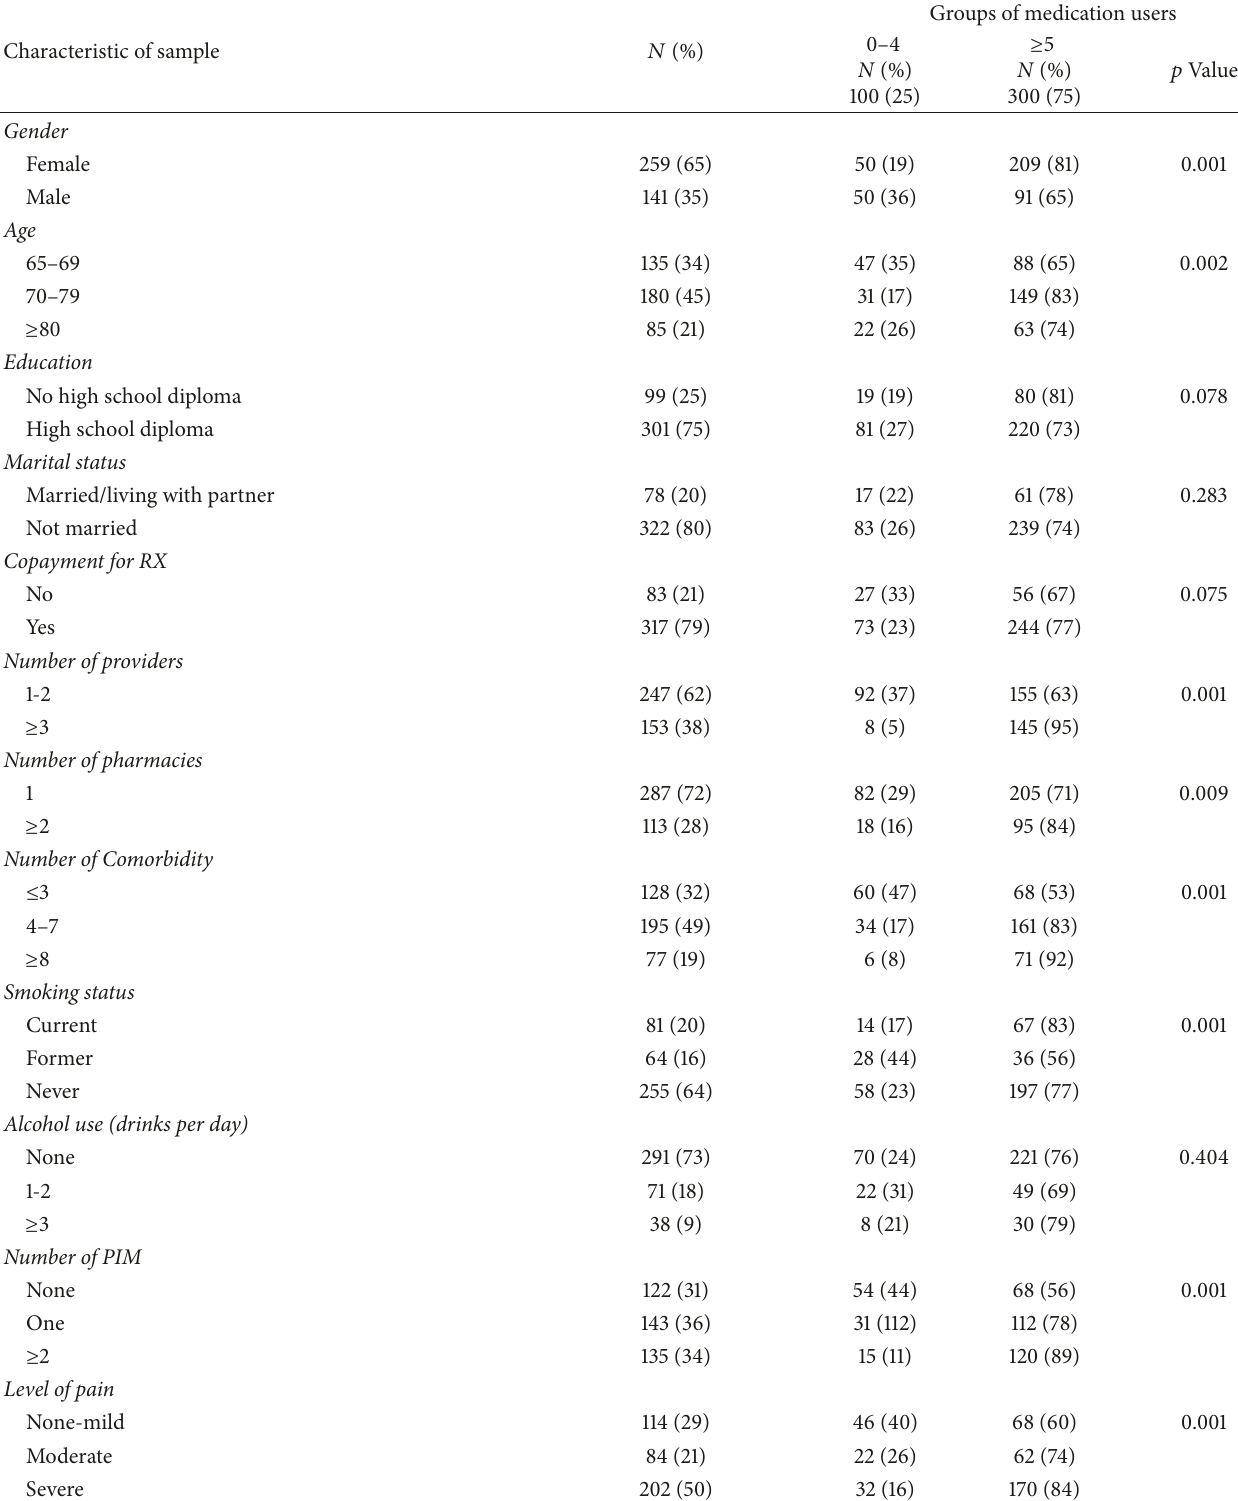
Table 1: Characteristics of study sample by high versus low medication use ( 𝑁 =